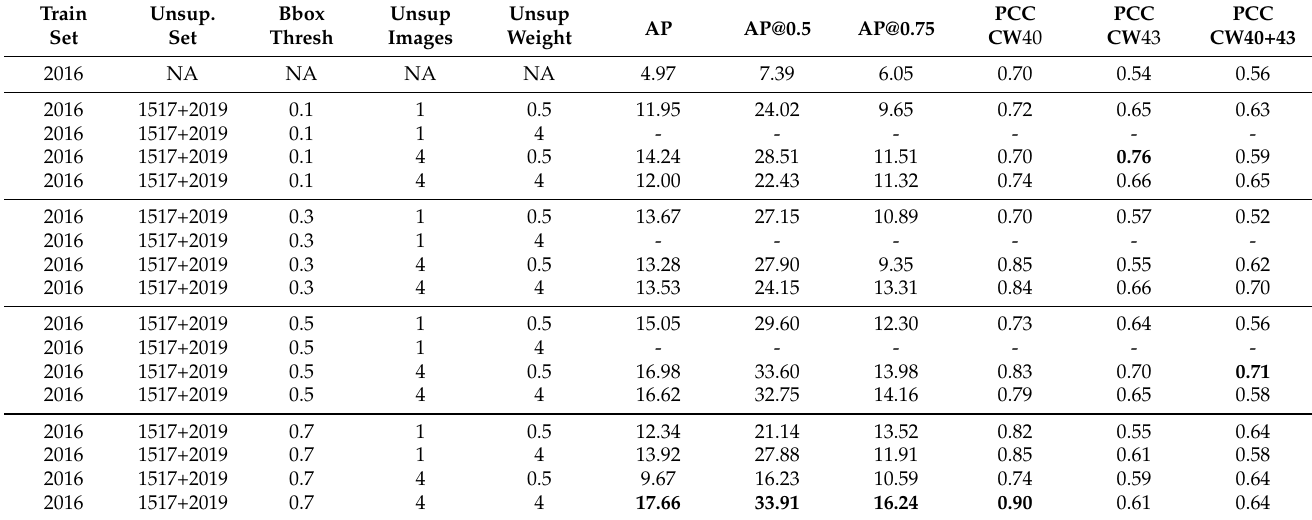
Table 9. Results for SSL-trained models for models with various hyper-parameters on the 2016 annotated dataset together with unannotated images from harvests from 2015, 2017, and 2019. Additional results are also shown for baseline fully supervised models in the first